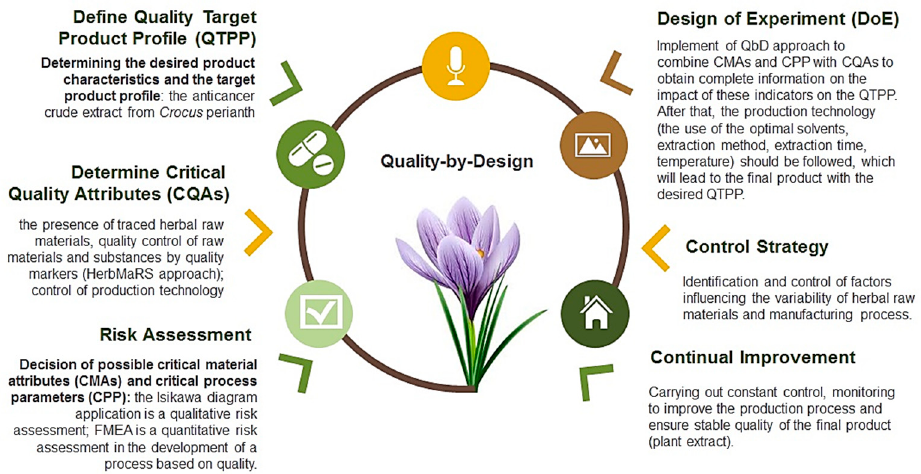
Figure 1. The QbD approach to quality assurance in Crocus perianth drugs production. Adopted by [5,6,19].